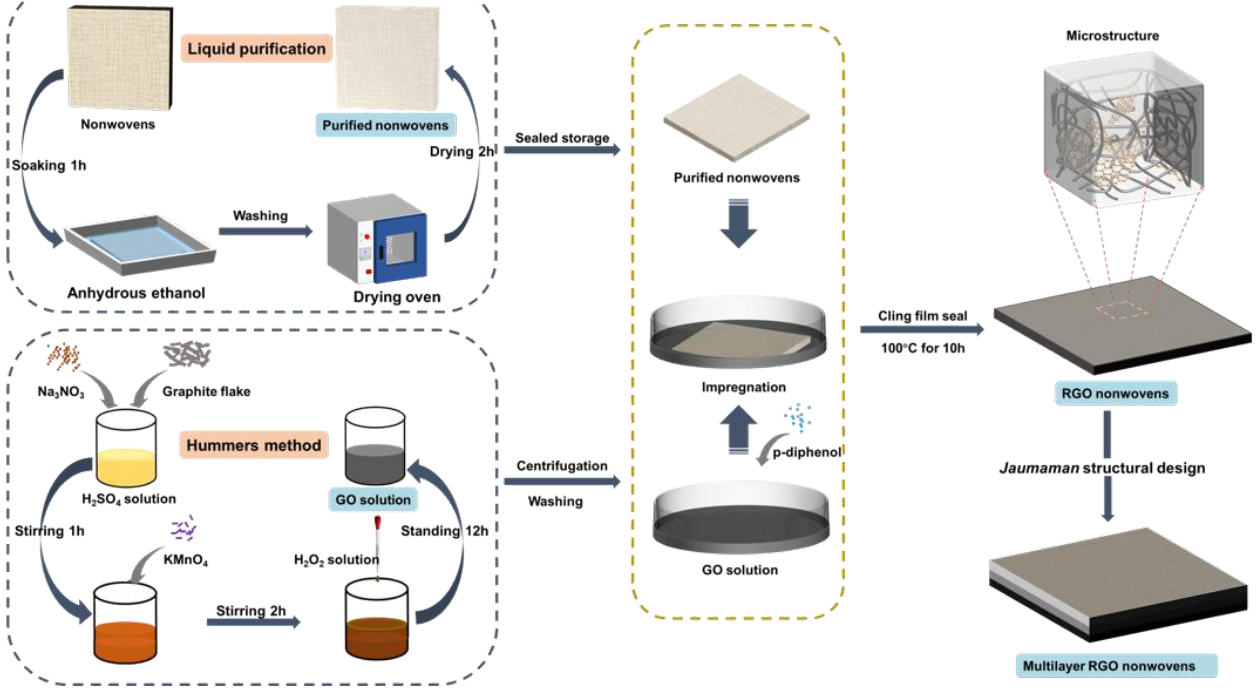
Figure 1. Preparation process of RGO/NW composite.